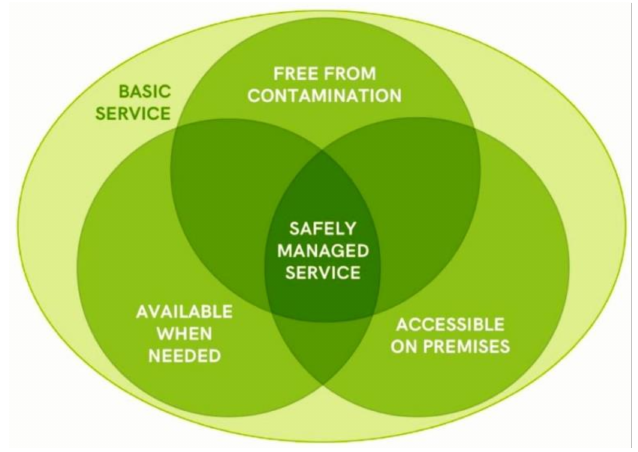
Figure 3. Elements of access to safely managed household water services.